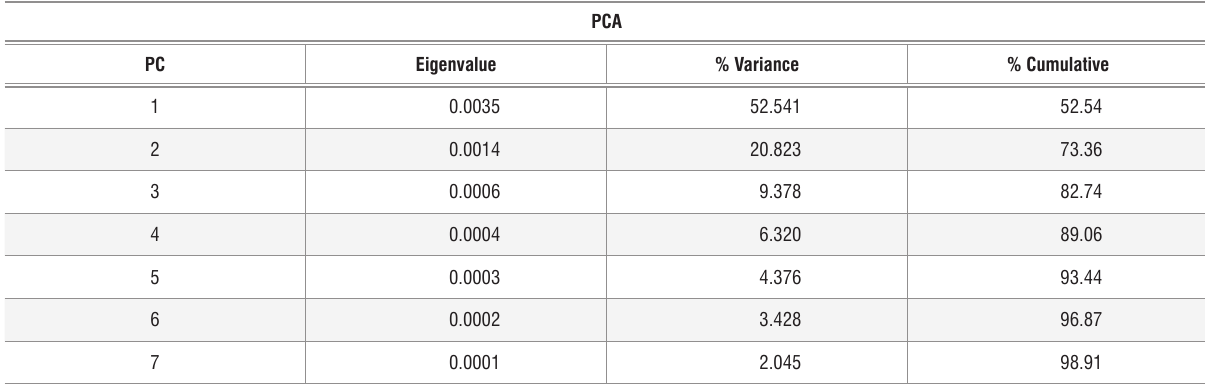
Summary statistics for the principal components analysis (PCA): pooled-sample shape data